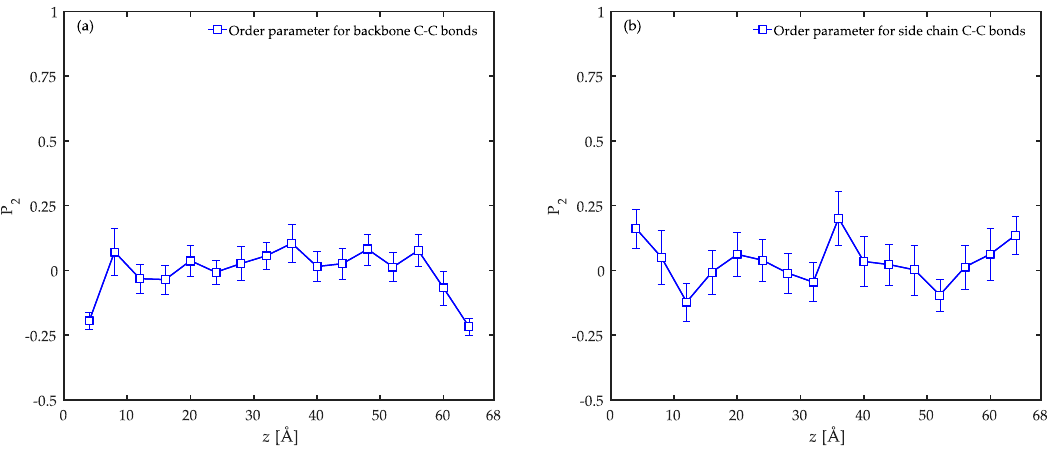
Figure 5. Local order parameter ( P 2 ) for C–C bonds in ( a ) backbone and ( b ) with side chains as a function of distance from the surface of the substrate. The results are calculated for the confined PP/Fe 2 O 3 system at 458 K and 1 atm. PP/Fe 2 O 3 system at 458 K and 1